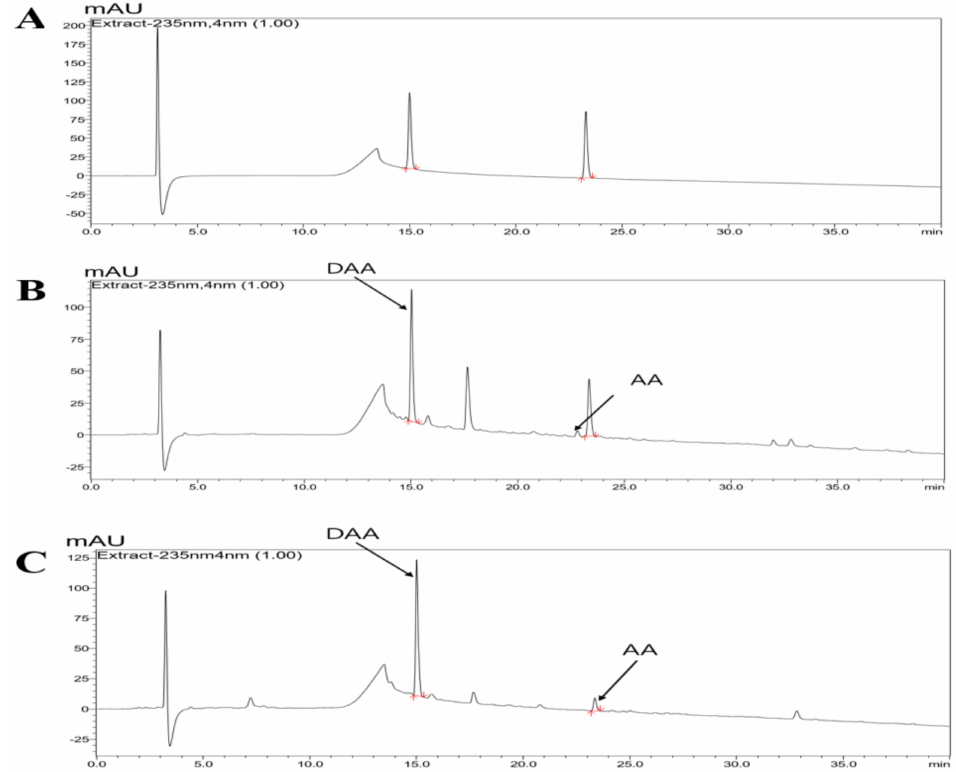
Figure 1. Representative HPLC-PDA chromatogram of noni and f. noni. ( A ) Standard; ( B ) noni extract powder; and ( C ) F. noni extract powder. The arrows represent DAA and AA (standard DDA Rt: 14.95 ± 0.08 min, noni and f. noni each 15.01 ± 0.04 and 15.01 ± 0.03 min; standard AA Rt: 23.27 ± 0.07 min, noni and f. noni each 23.34 ± 0.06 and 23.34 ± 0.04 min). Table 1. Content of DAA and AA in the Noni and F. noni extract